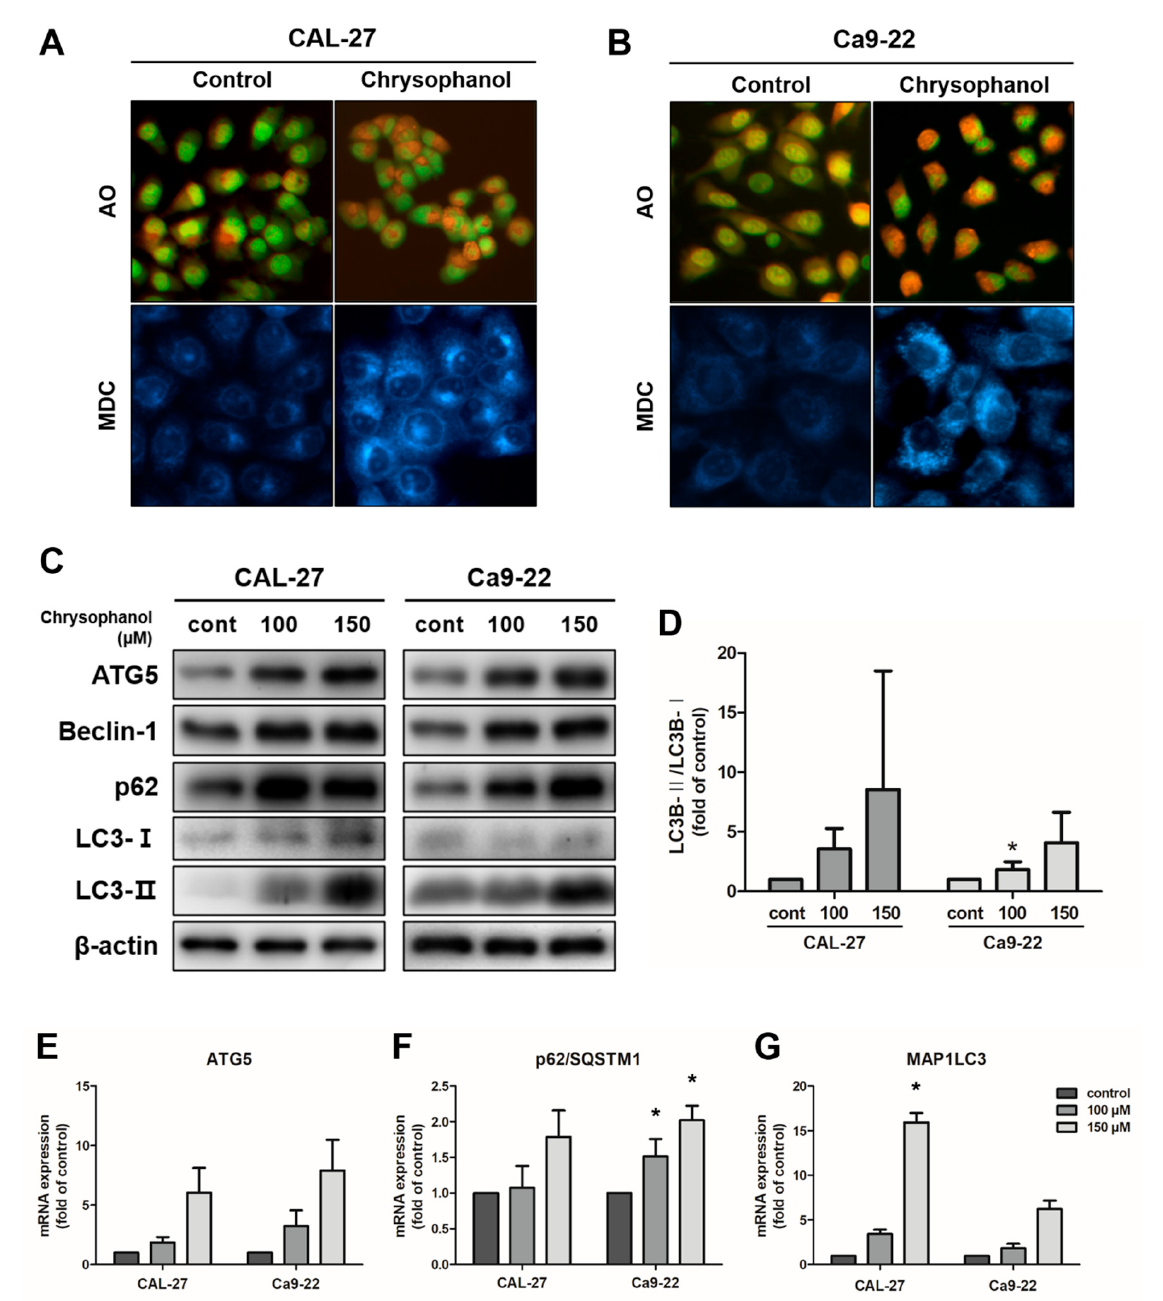
Figure 4. Chrysophanol-induced autophagy in CAL-27 and Ca9-22 cells. ( A , B ) The cells were treated with 100 µ M chrysophanol. Then, acidic vesicular organelles’ (AVOs) formation was observed by AO staining, and MDC staining was used to detect the autophagic vacuole accumulation. ( C , D ) The expression levels of autophagy-related protein ATG5, beclin-1, LC3B-I/LC3B-II, and p62 were examined using a Western blot analysis, and the density of protein LC3B-II/LC3B-I ratios is shown in the graph. β -actin was used to present a loading control. ( E – G ) Autophagy-related mRNA expression levels, such as those of ATG5, beclin-1, p62/SQSTM1, and MAP1LC3B, were identified using a real- time PCR. GAPDH was used to present a loading control. Data are expressed as mean ± SD (* p < 0.05).